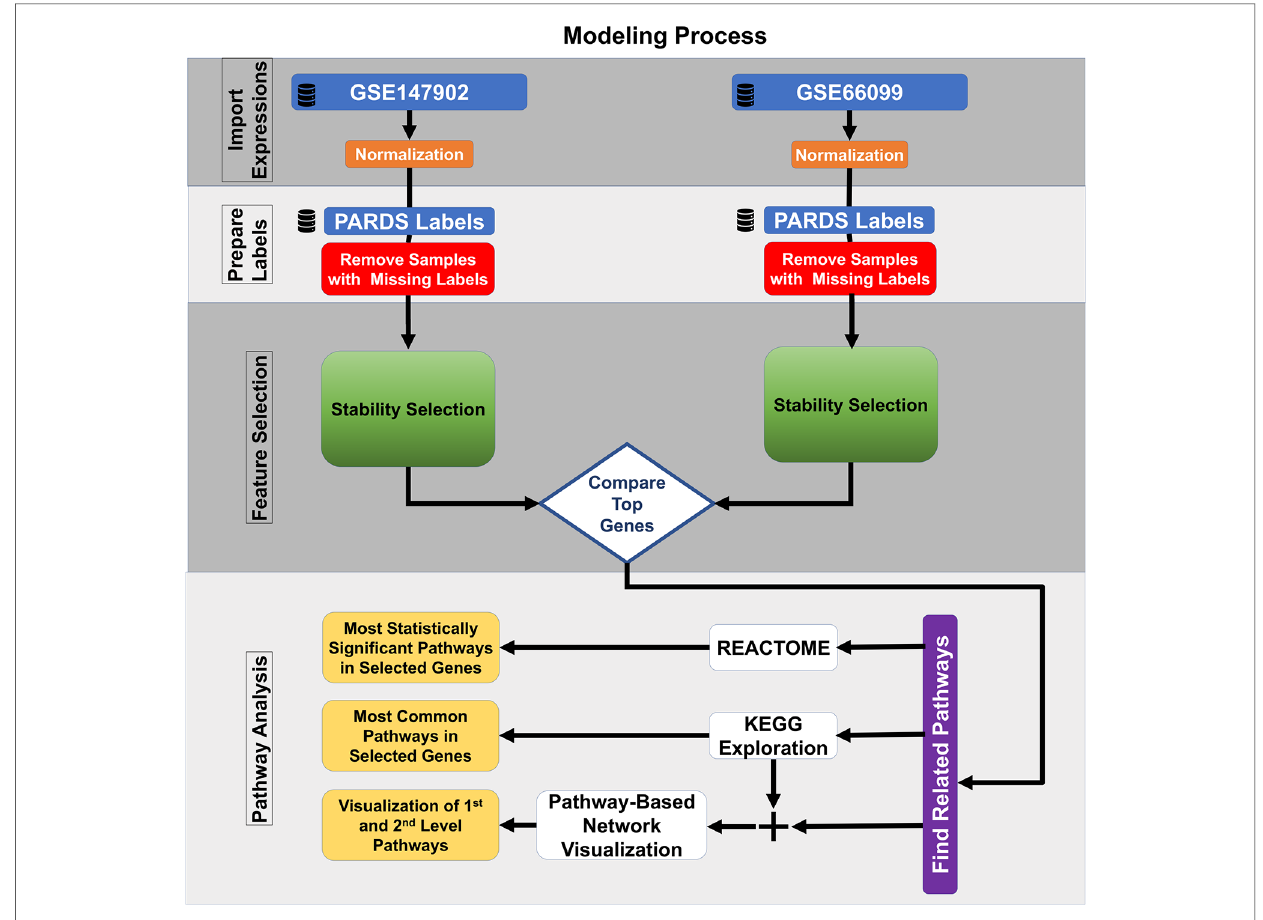
FIGURE 1 Machine learning feature selection